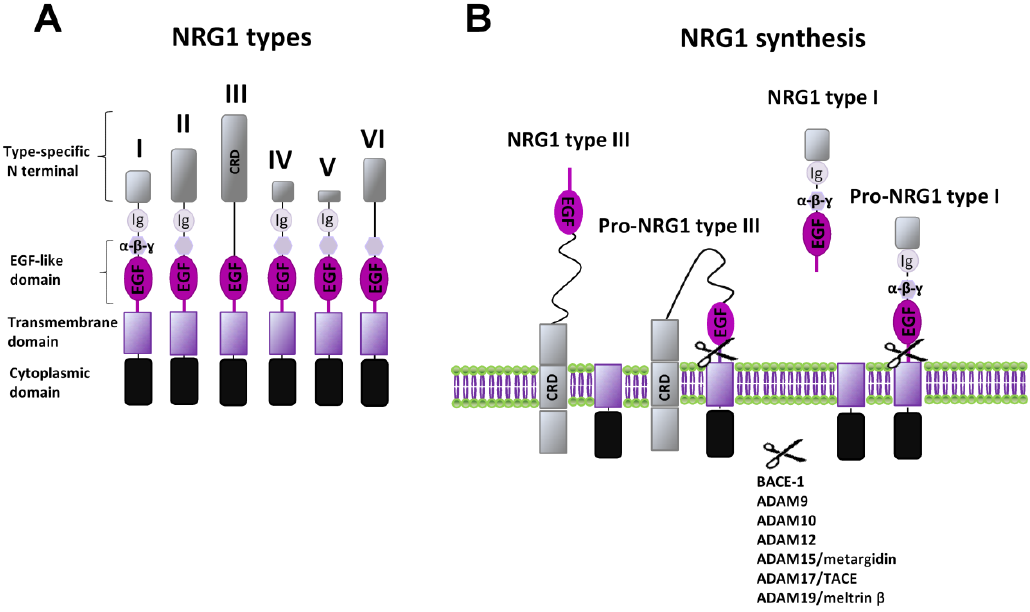
Figure 1. NRG1 types and synthesis. ( A ) Diagram of structural differences of various NRG1 types. ( B ) Synthesis of NRGs’ mature forms is induced by different ADAMs and MMPs, with the release of soluble forms (as for example for NRG1 type I) or the exposure of the membrane-anchored EGF-like domain (as for NRG1 type III).